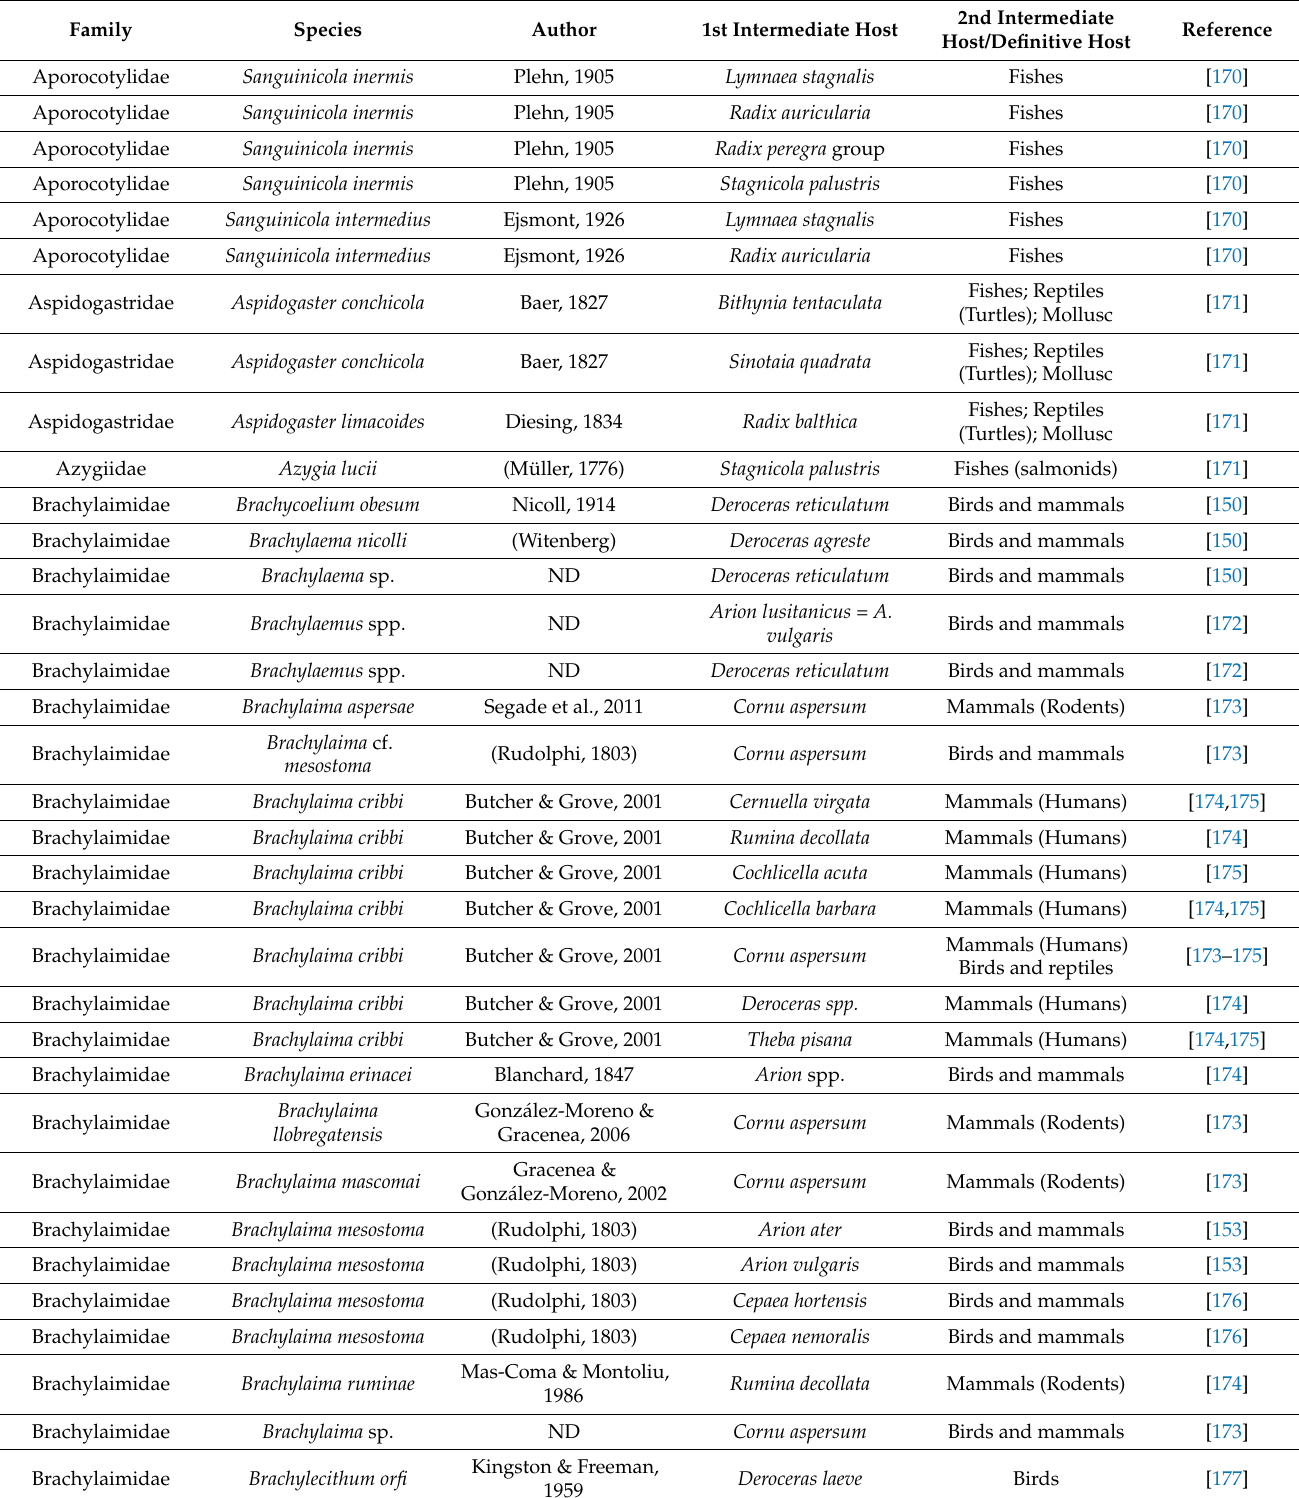
Table A3. Taxonomic list of the diversity of parasites and their intermediate hosts. ND: No